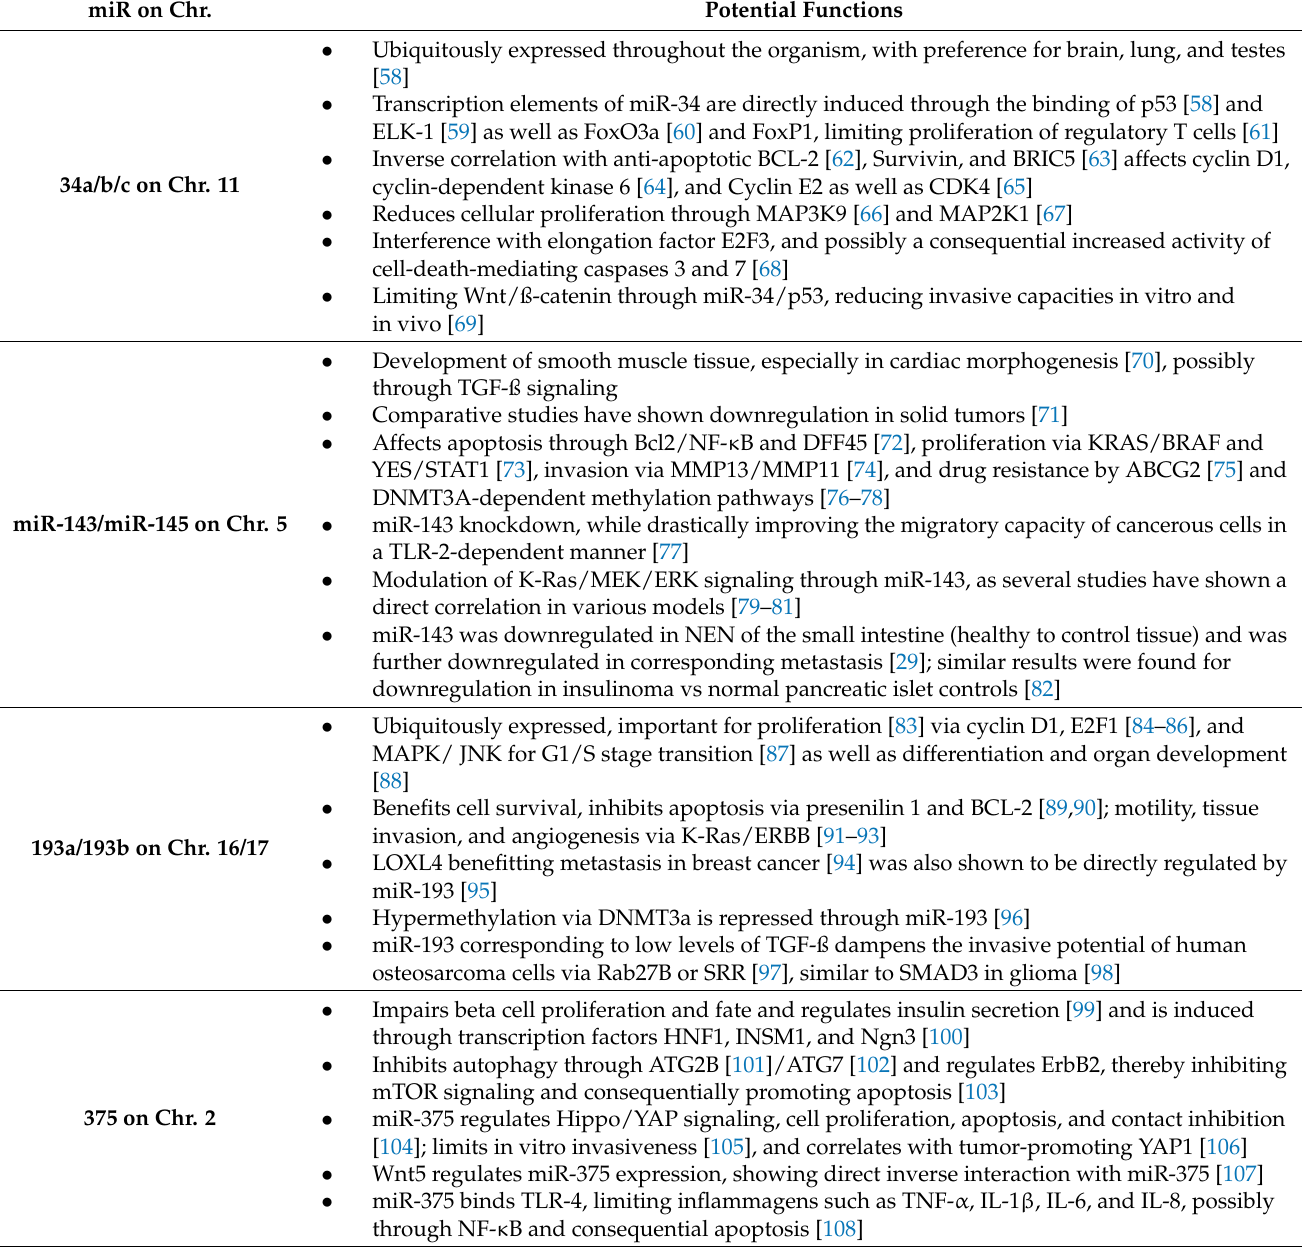
Table 1. Summary of additional potential NET-relevant miRNAs and their possible related functions in apoptosis, prolifera- tion, differentiation, methylation, drug resistance, and immune cell modulation. miR on Chr. Potential Functions